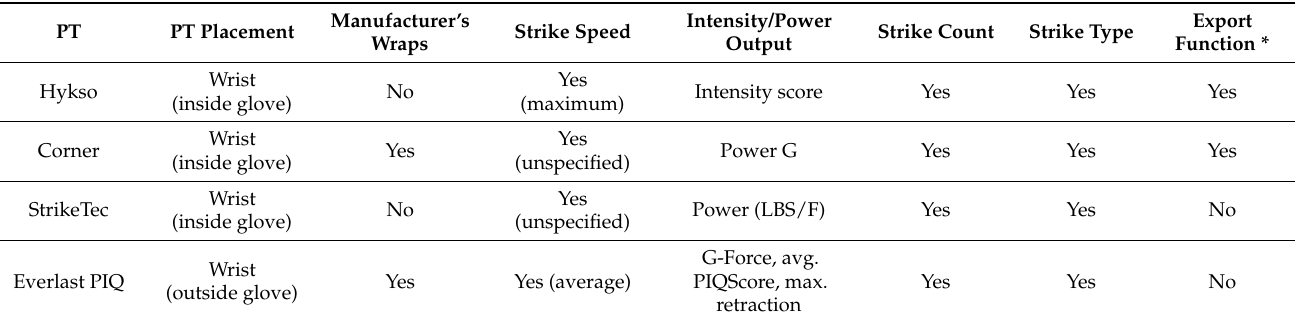
Table 2. Information provided by each punch tracker